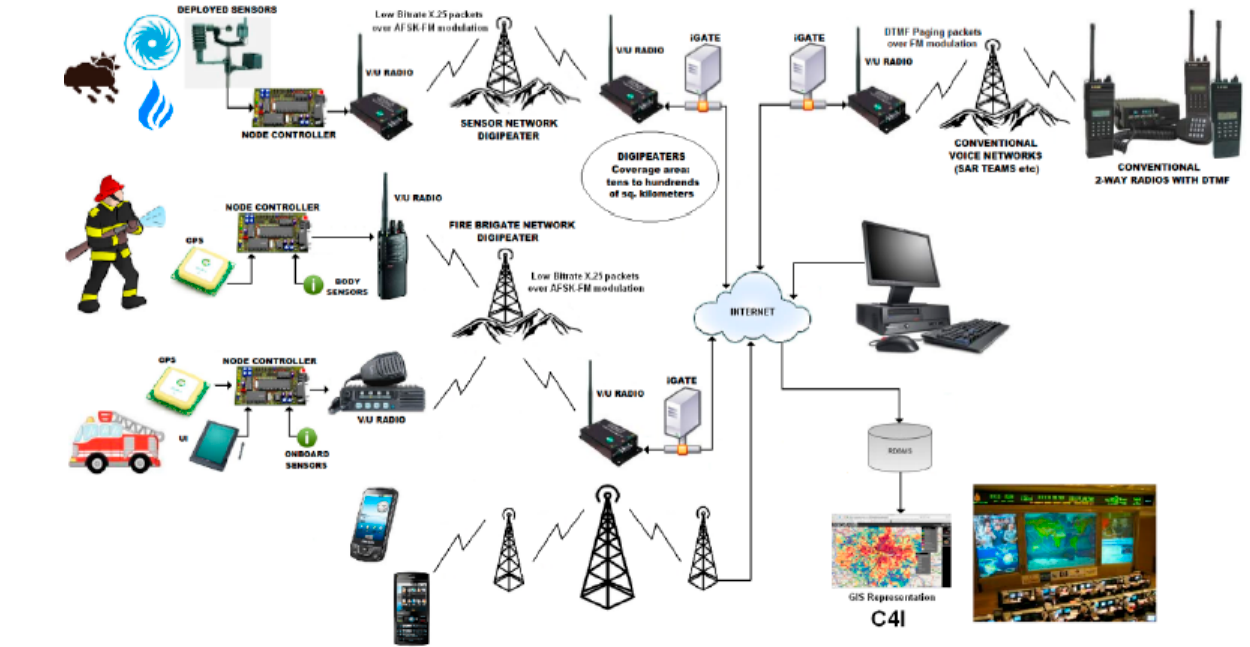
Figure 2. Cyber-Physical System (CPS) with Internet-of-Things (IoT) sensors. Table 4. Summary CPS constructs and methods in